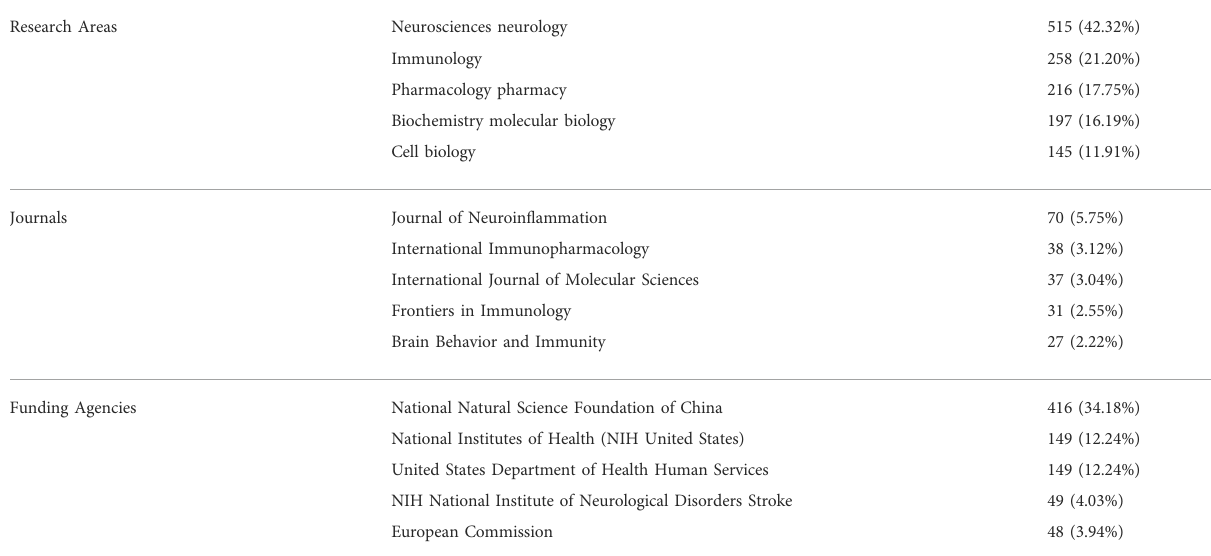
TABLE 1 Top fi ve based on the number of documents (2010 – 2022).